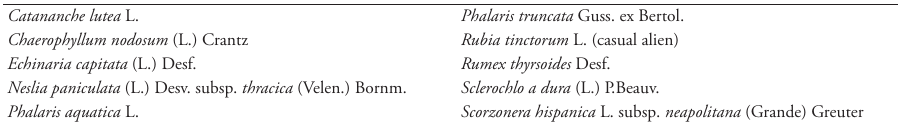
Table 4. List of taxa confirmed for Campania. Catananche lutea